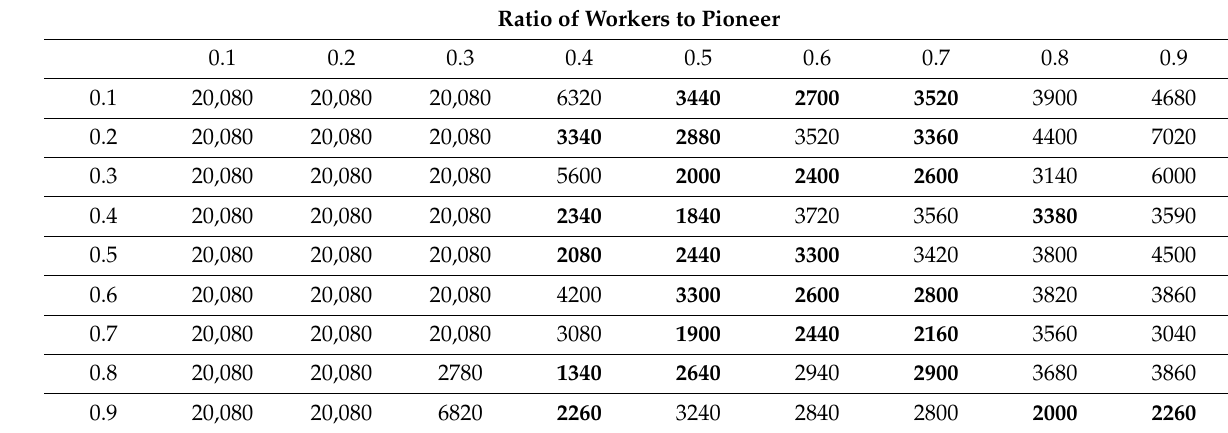
Table 3. Average NOFE with different parameter settings in the Dixon-Price function (10